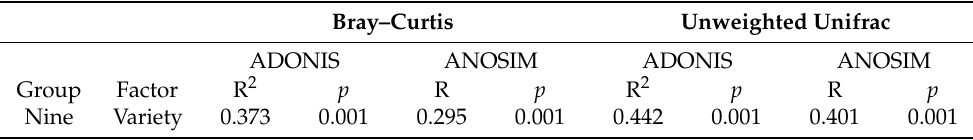
Table 4. The taxonomic metric (calculated from OTU) for fungal diversity